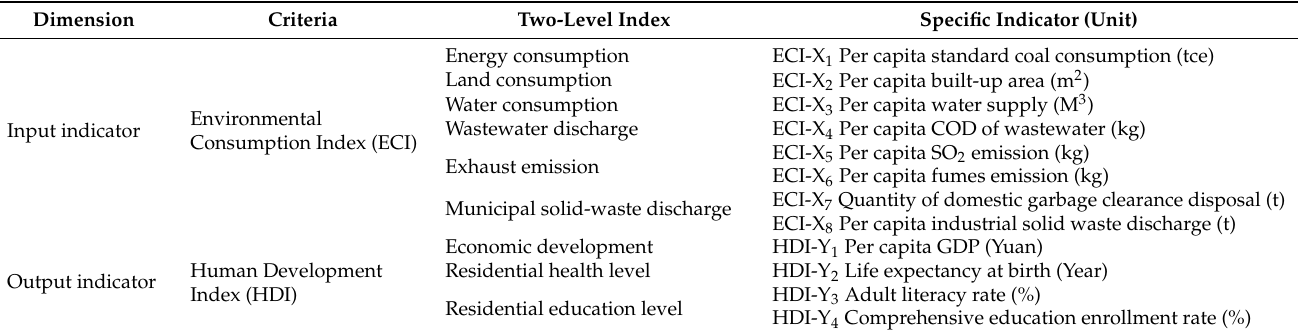
Table 3. Main feature descriptions for the evaluation indicator system of